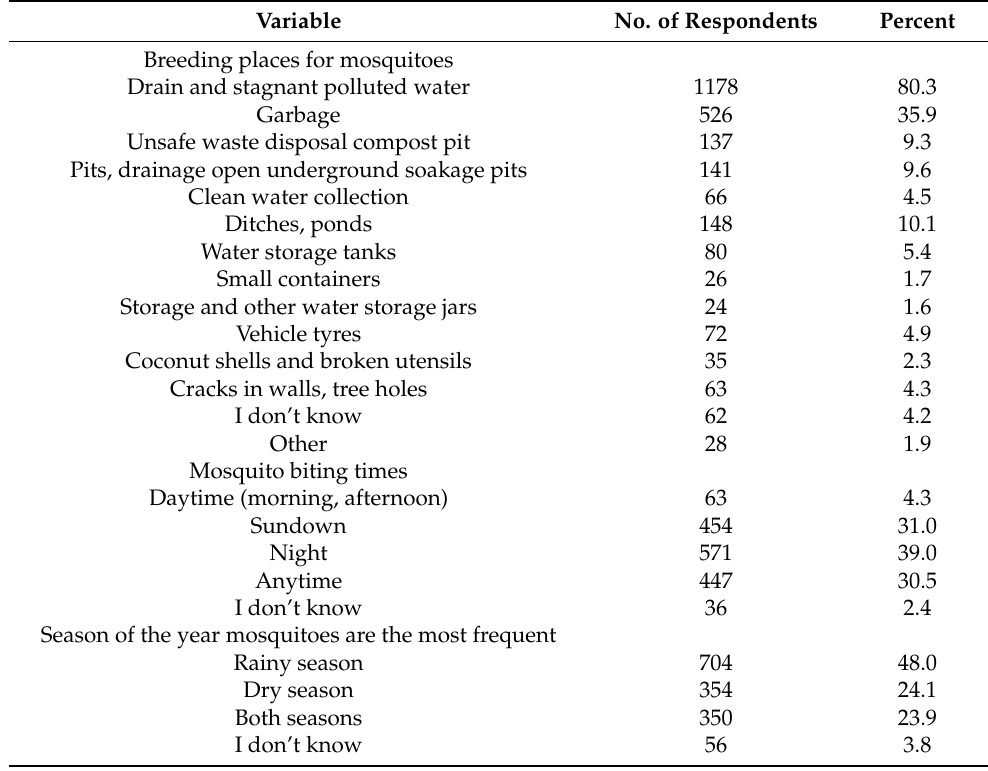
Table 3. Knowledge related to mosquito biology, vector role, and preventive